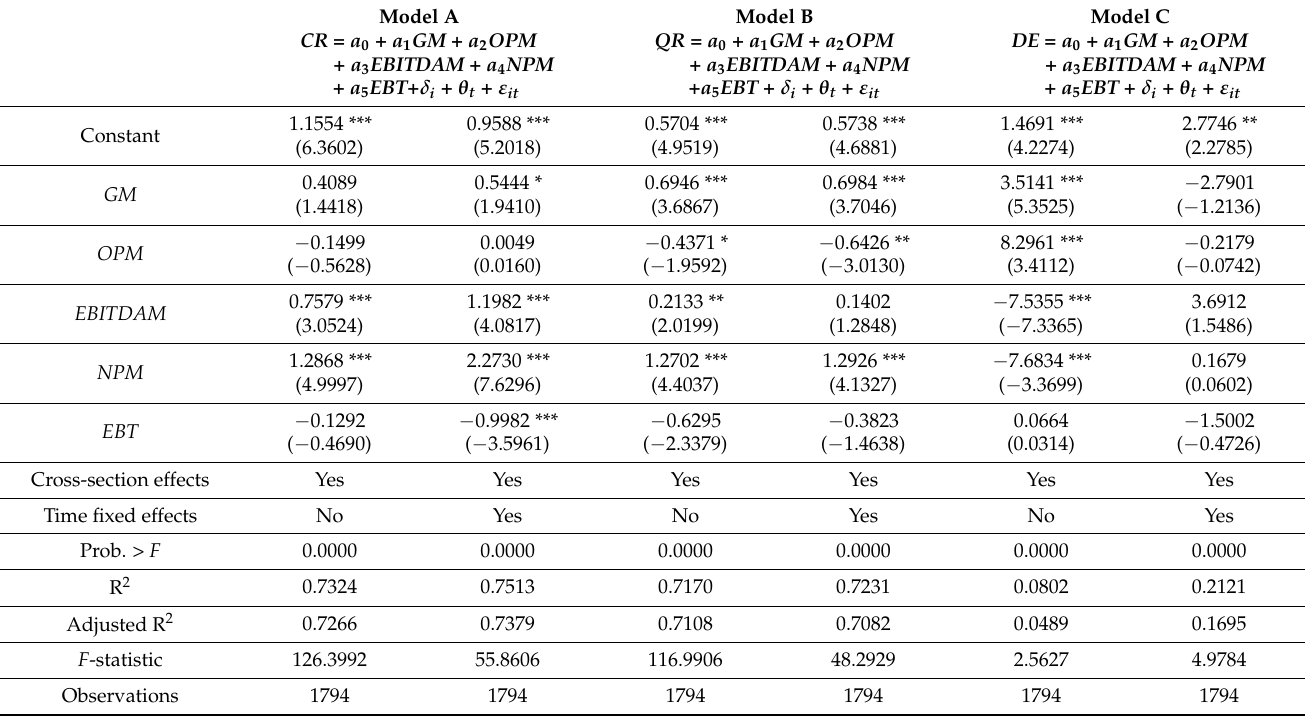
Table 3. Econometric models corresponding to the dependent variables CR , QR and DE for the selected